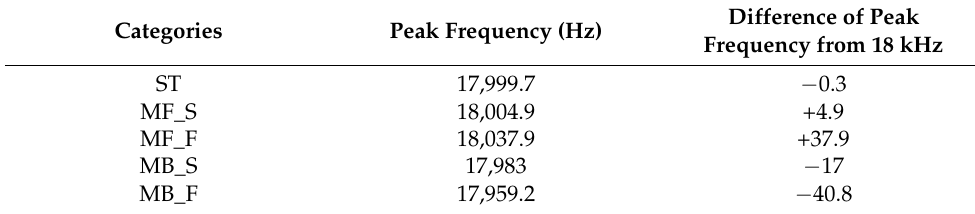
Table 1. Comparison of Peak Frequencies from the Indoor Experiment.